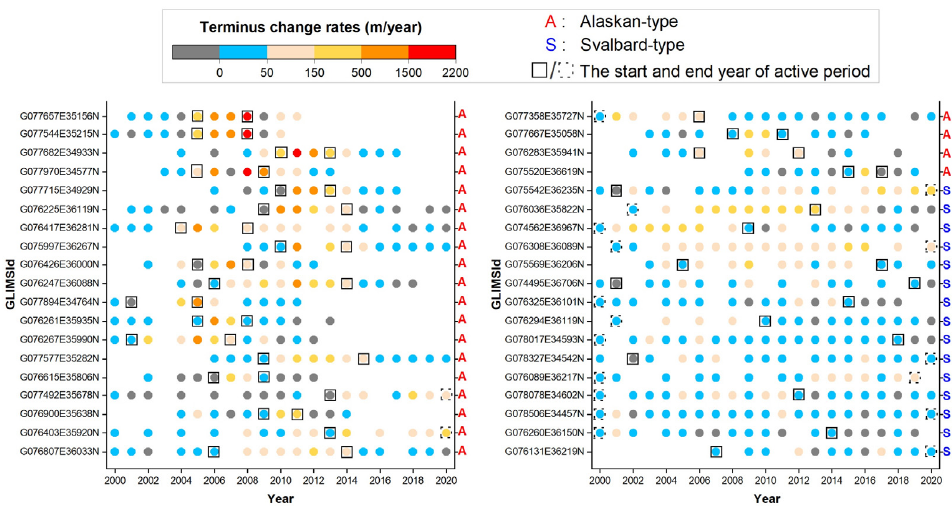
Figure 7. Temporal evolutions of glacier-terminus-change rates for the 38 clean-ice or partly debris-covered surge-type glaciers during 2000–2020. The start and end years of the active period are flagged with squares with solid black outlines. The black squares with dashed outlines indicate that the exact start year or end year of the active period is not discernible for some ongoing surging glaciers (particularly the Svalbard type). Measurements are absent for certain years due to the availability of free images with no obvious seasonal snow.